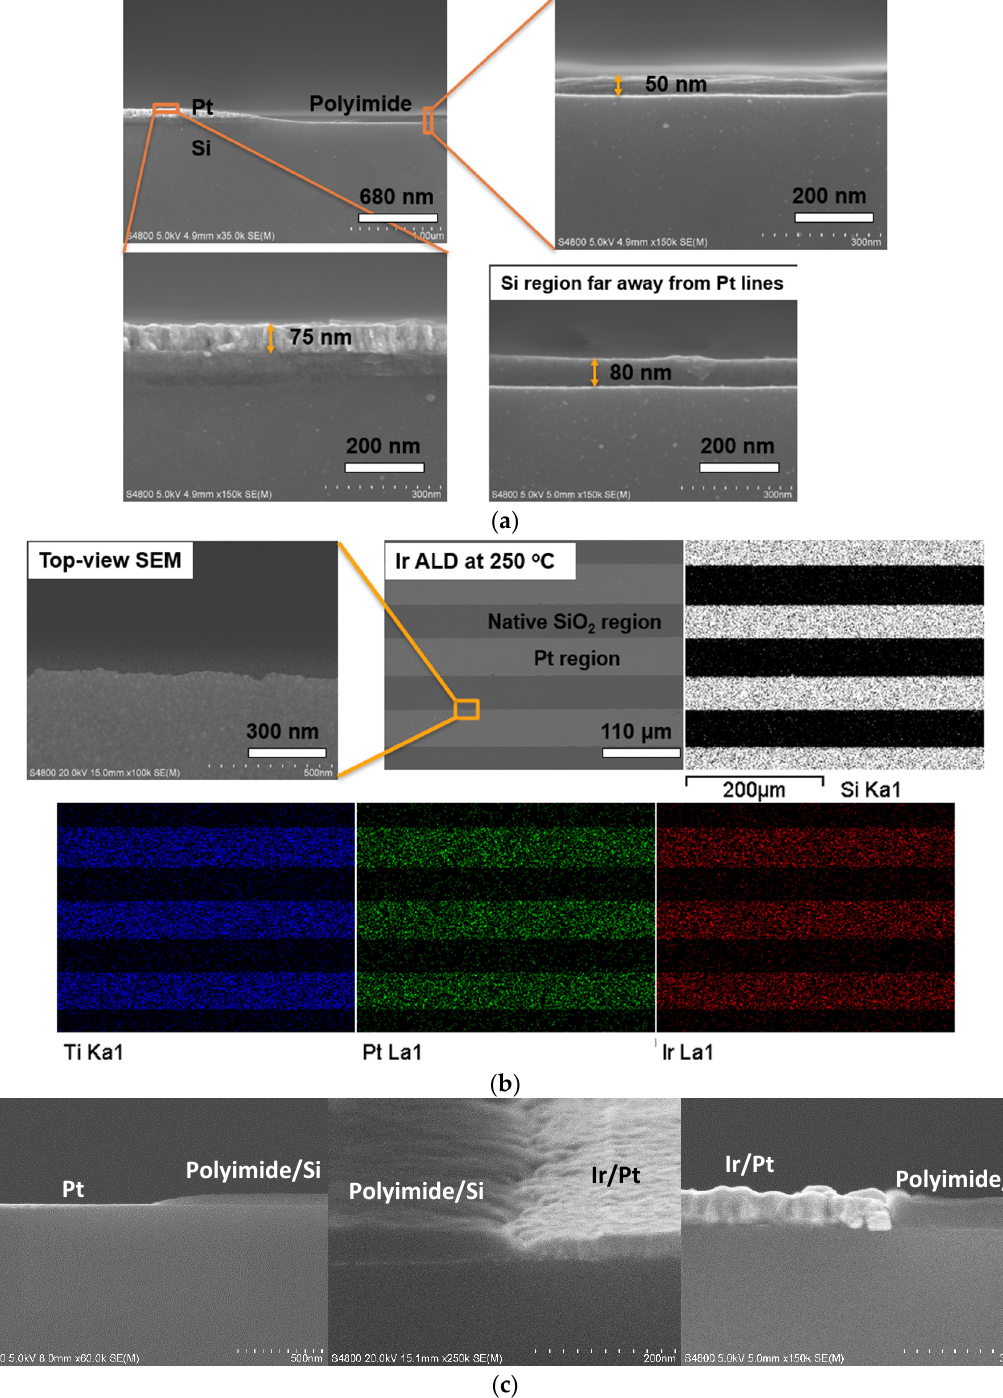
Figure 3. ( a ) Cross-sectional SEM images showing the success of area-selective etching of polyimide films on a patterned Pt/SiO 2 sample. ( b ) Top-view SEM images and the corresponding EDX maps demonstrating the success of the subsequent area-selective ALD of Ir on Pt. ( c ) SEM images of the SiO 2 –Pt boundary after the polyimide etching ( left ) and Ir deposition ( middle ). The image on the ( right ) shows a cross section of the SiO 2 –Pt boundary from a sample wherein the line was patterned with a lift-off process and then processed similarly.